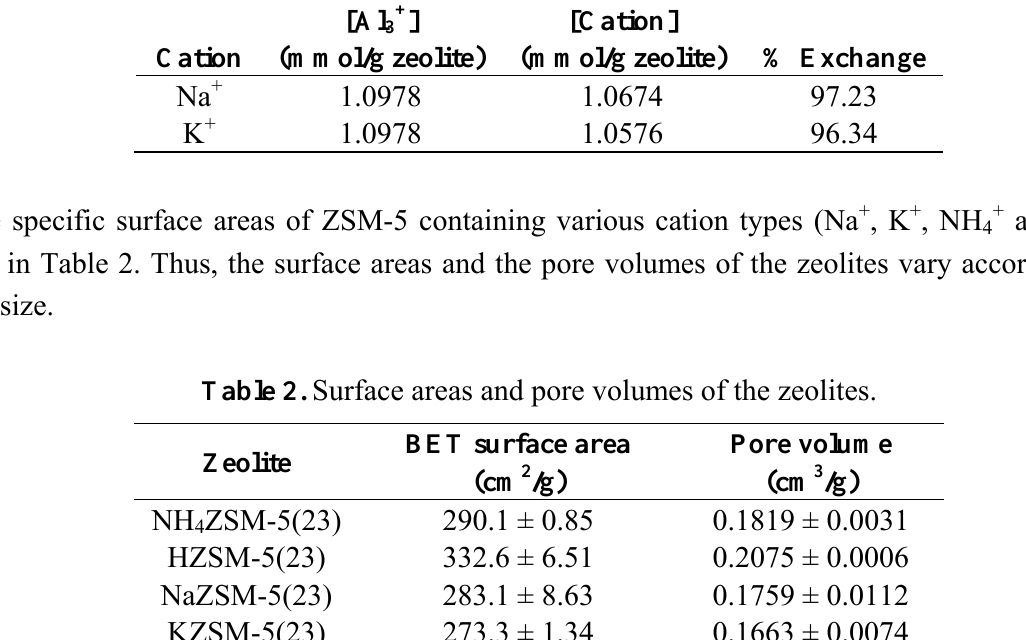
Table 1. The cation exchange levels of NH